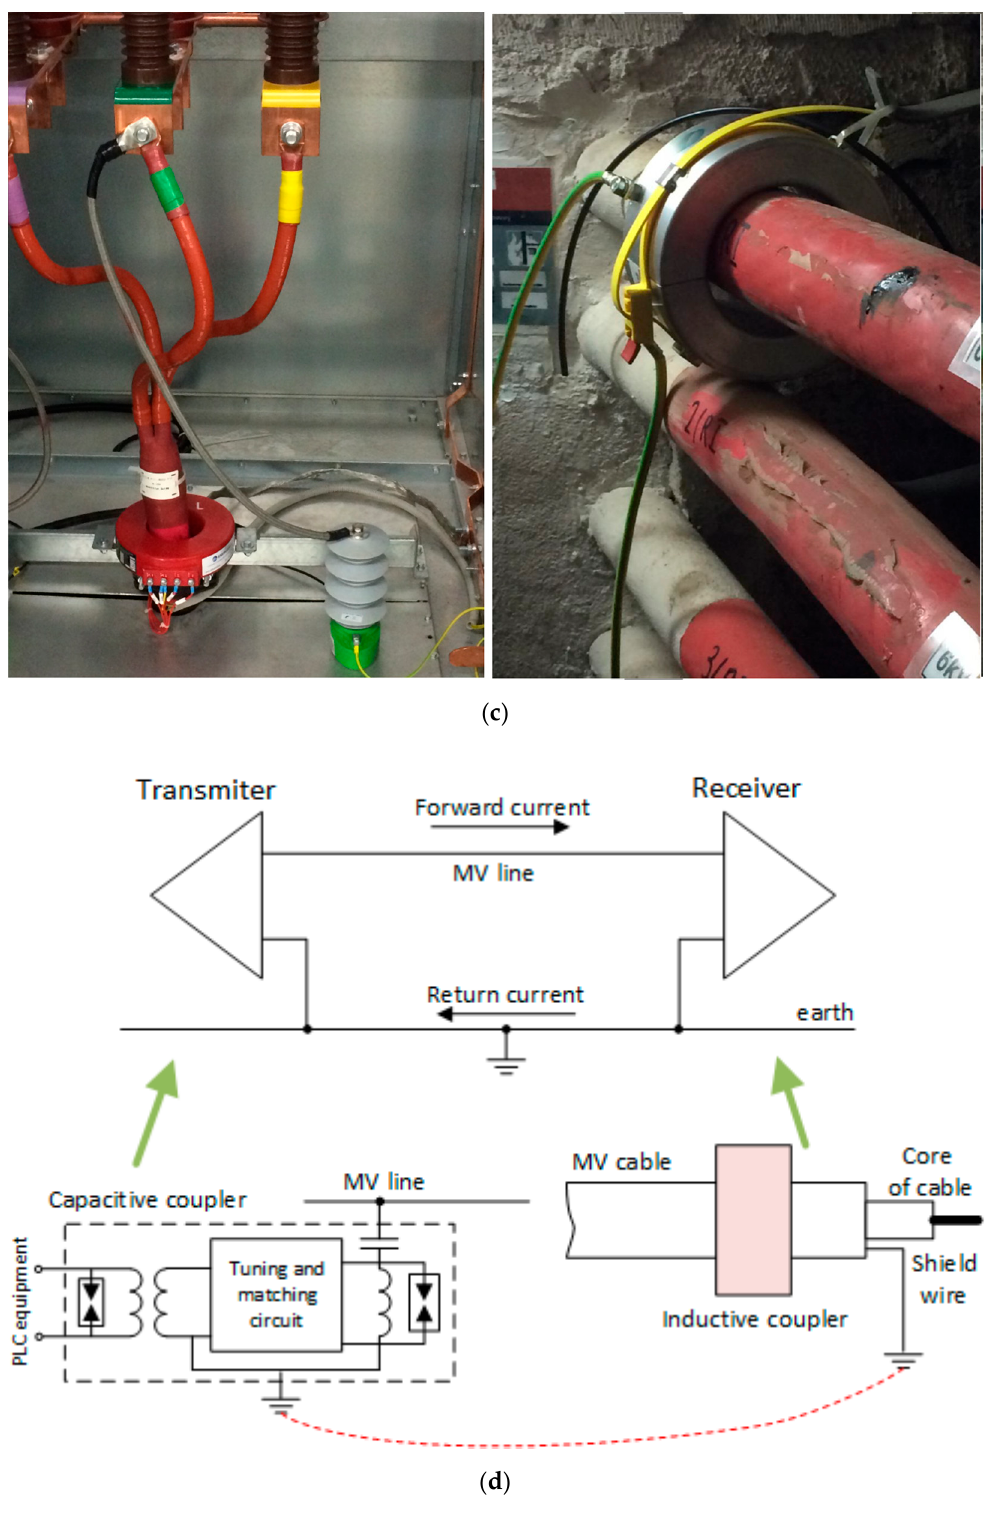
Figure 3. Layout for the BPL transmission tests: ( a ) Inductive-inductive coupling; ( b ) Capacitive-inductive coupling; ( c ) Physical installation of capacitive and inductive couplers; ( d ) Schematic of the signal propagation.